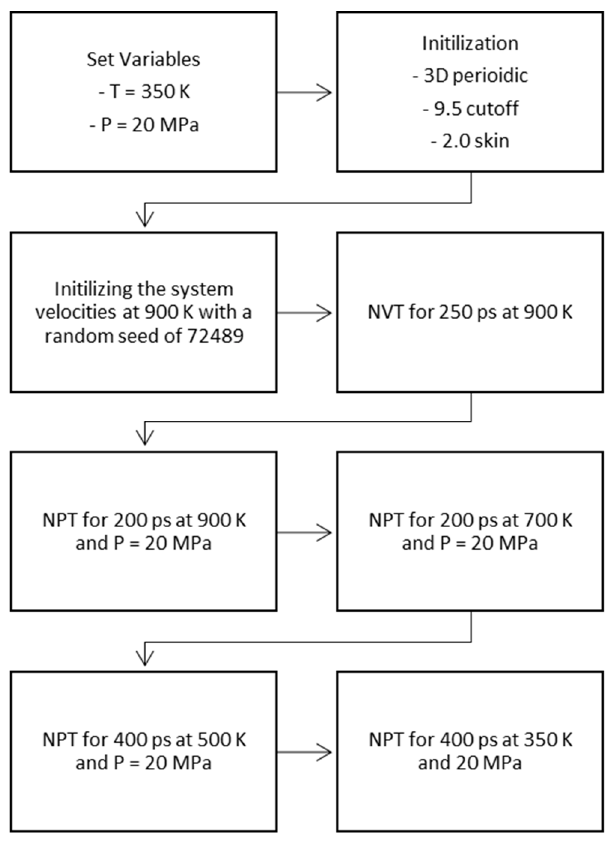
Figure 2. Formation of nanoporous kerogen structures. Molecules 2020 , 25 , x FOR PEER REVIEW